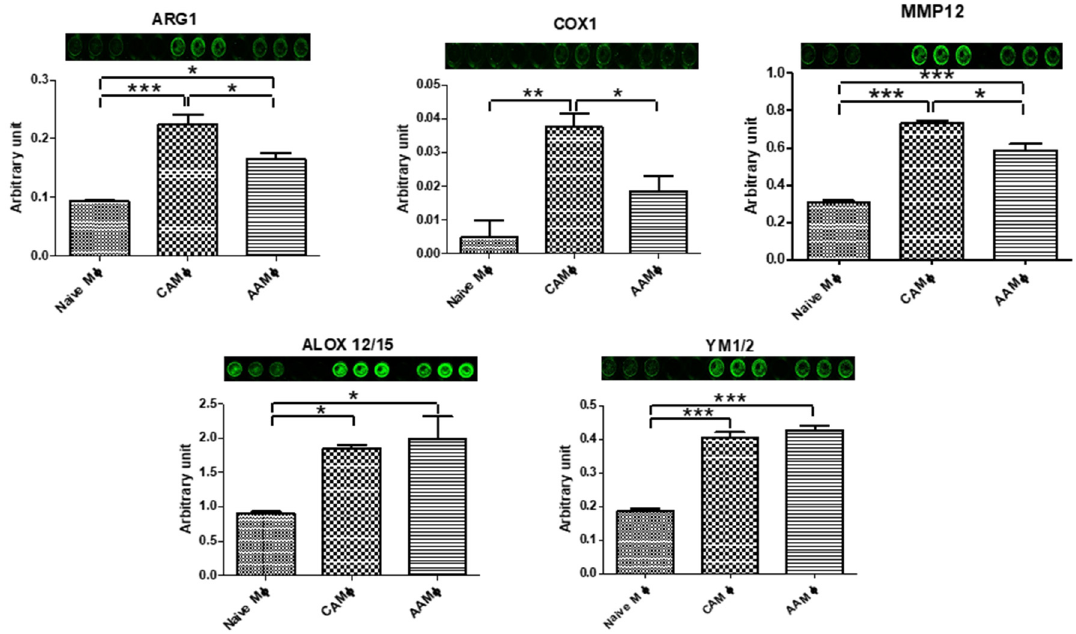
markers (Figure 6).